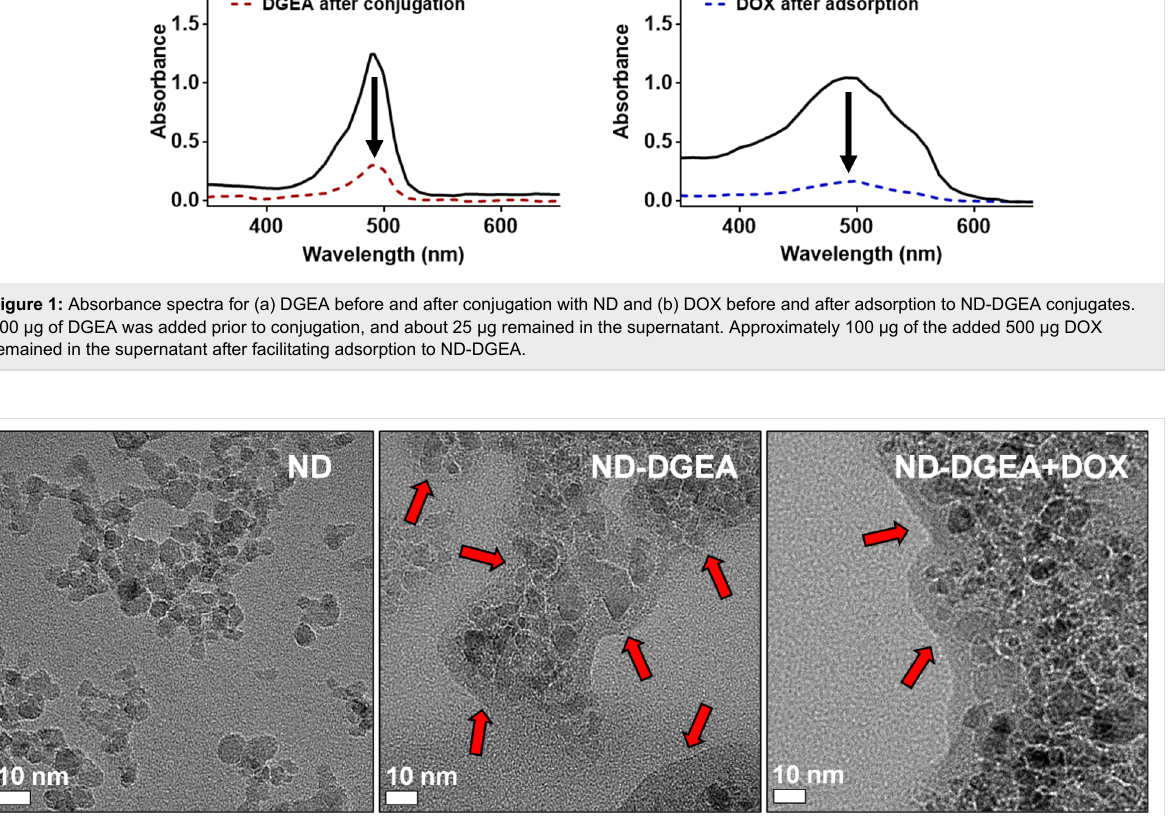
gated DGEA surrounding the NDs, as ND and DGEA were